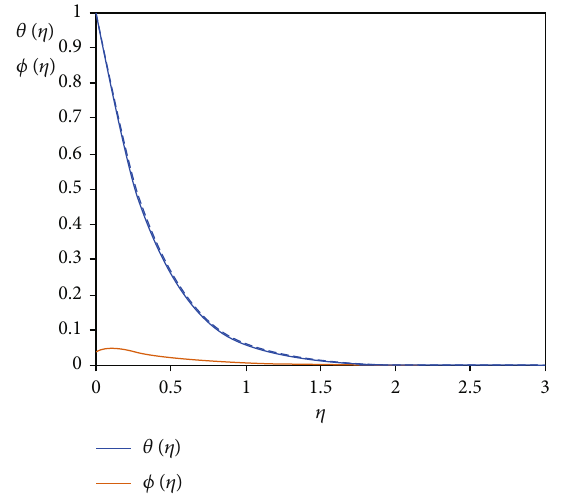
Figure 4: Concentration and temperature pro fi les a ff ected by the Weissenberg number.